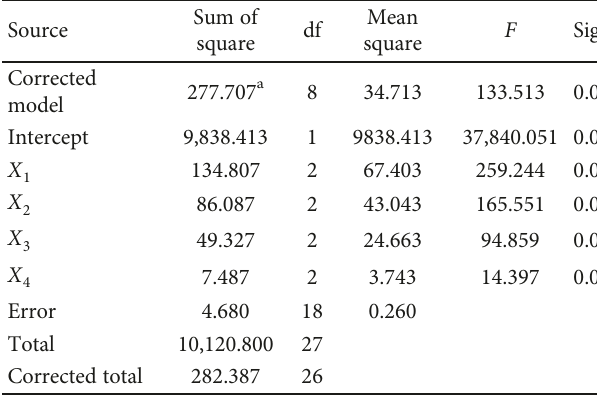
Table 4: Variance analysis of the orthogonal